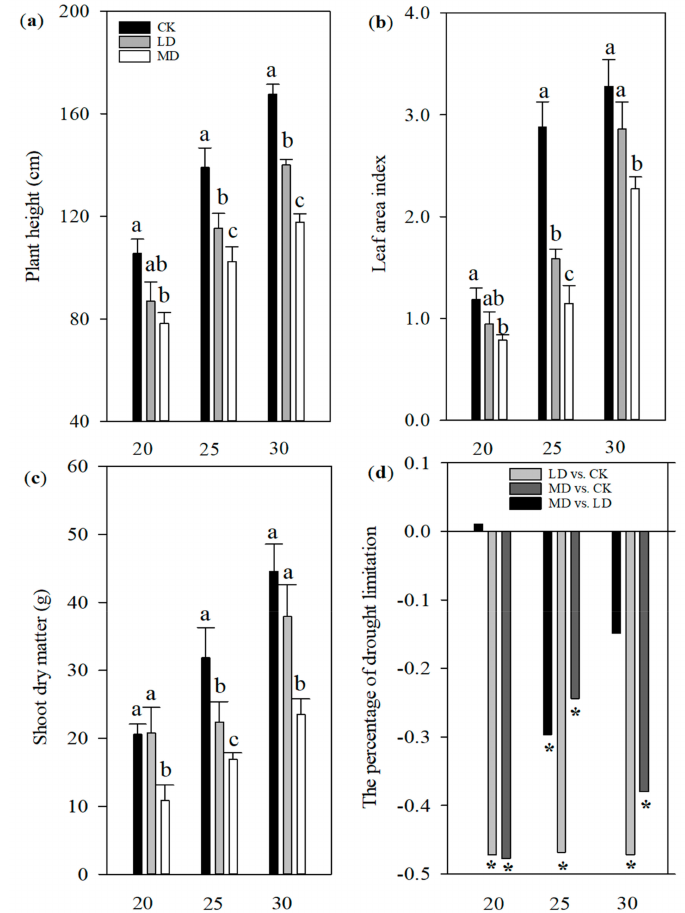
Figure 1. Agronomic traits changes of maize plants in response to di ff erent drought stress. E ff ect of drought stress on ( a ) plant height; ( b ) leaf area index; ( c ) shoot dry matter; and ( d ) the percentage of drought limitation at 20, 25, and 30 days after drought (DAD). Values are the means of the replicates ± sd. Di ff erent lowercase letters and * symbols indicate statistical significance of di ff erences at a p < 0.05 level. There were three treatments, including well-watered (CK), light drought (LD), and moderate drought (MD), and five biological replicates were sampled for each treatment.